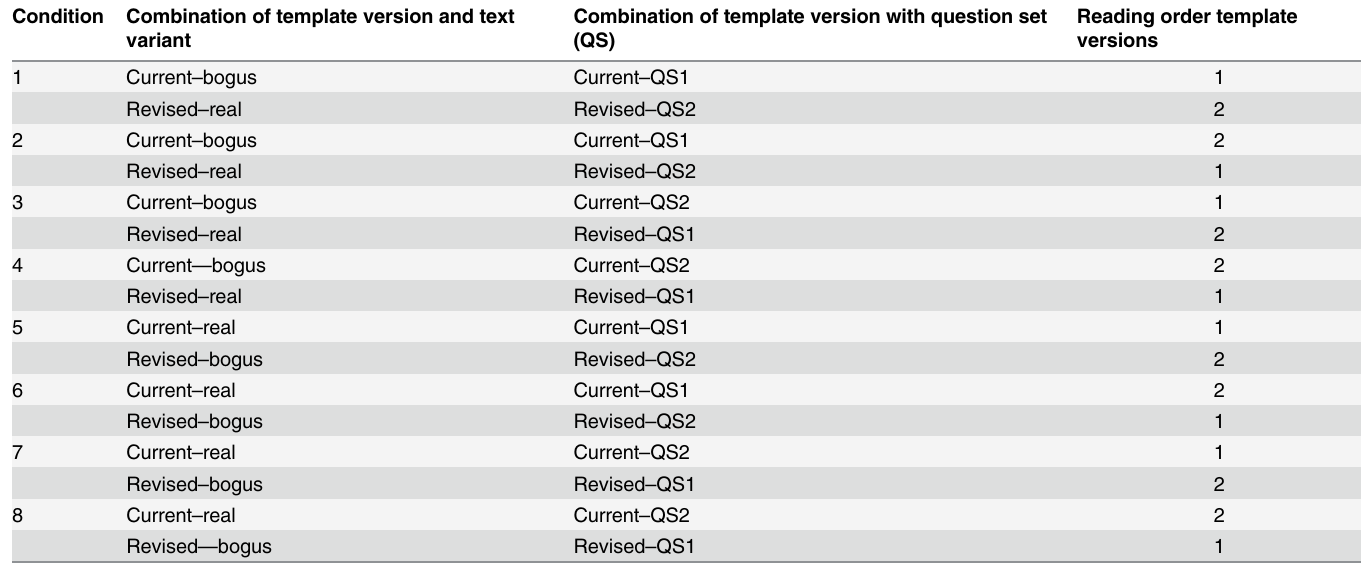
Table 4. The eight-cell design used in both countries; participants in each cell see both a current (C) and a revised (R) template. Condition Combination of template version and text variant